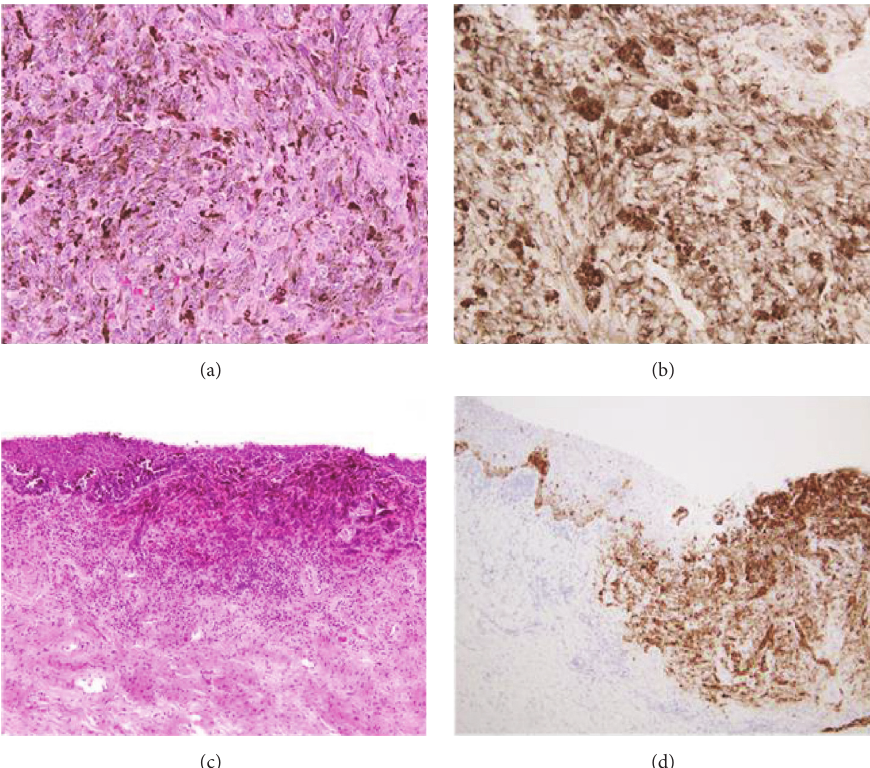
Figure 3: Pathological findings of the cervix revealed spindle-shaped tumor cells showing intracytoplasmic melanin (a) and strong reactivity for melan-A (b). There were similar findings in the vagina (c, d). The invasion depth of the cervical tumor was deeper than that of the vaginal tumors. Magnification: (a) × 400, (b) × 400, (c) × 40, (d) ×